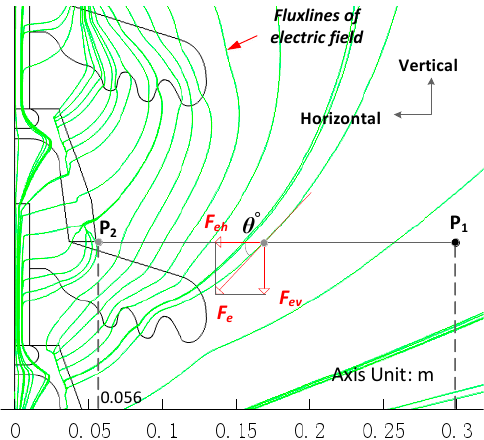
Figure 2. Diagram of the sampled path near the insulator string.